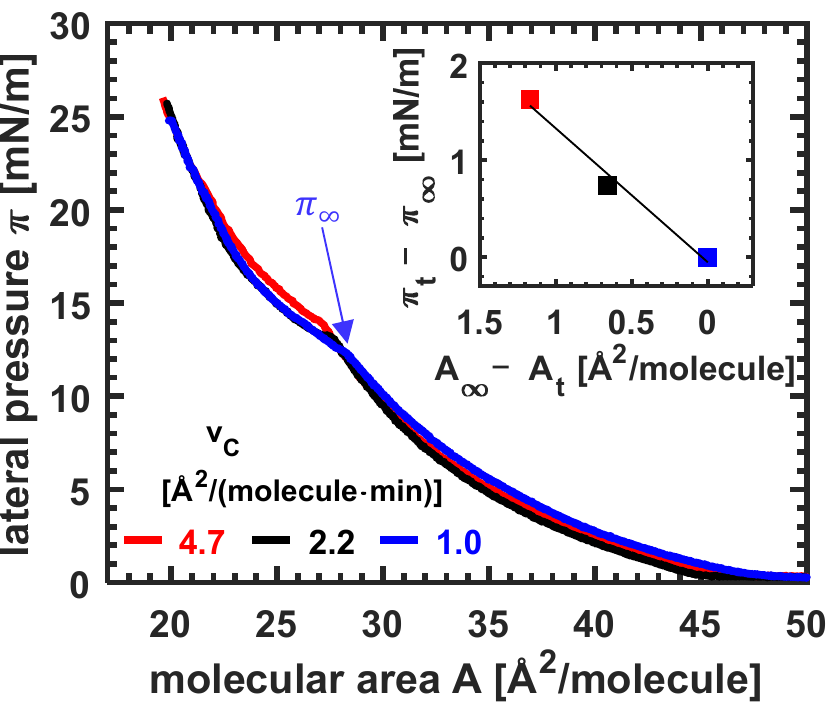
Figure 1. Isotherms of erucic acid monolayers at different compression velocities v C at pH 3, T = 10 ◦ C. The inset shows the shift of the phase transition lateral pressure π t − π ∞ in dependence on the shift in the molecular area, A ∞ − A t , while v C is increased. A blue arrow marks the transition pressure 𝜋 for the isotherm measured at the lowest compression velocity, which is approximated as the equilibrium isotherm.